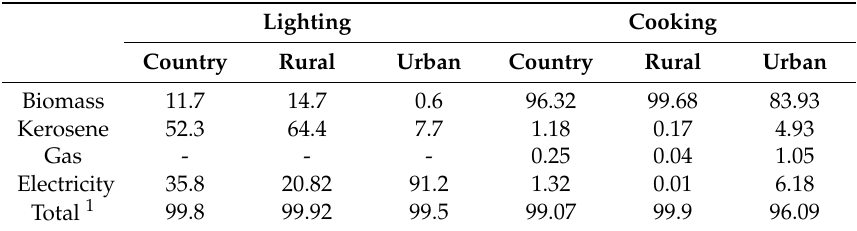
Table 1. Percentage of Lighting and Cooking Technology/Fuel Utilization, 2011 (Unit: %).